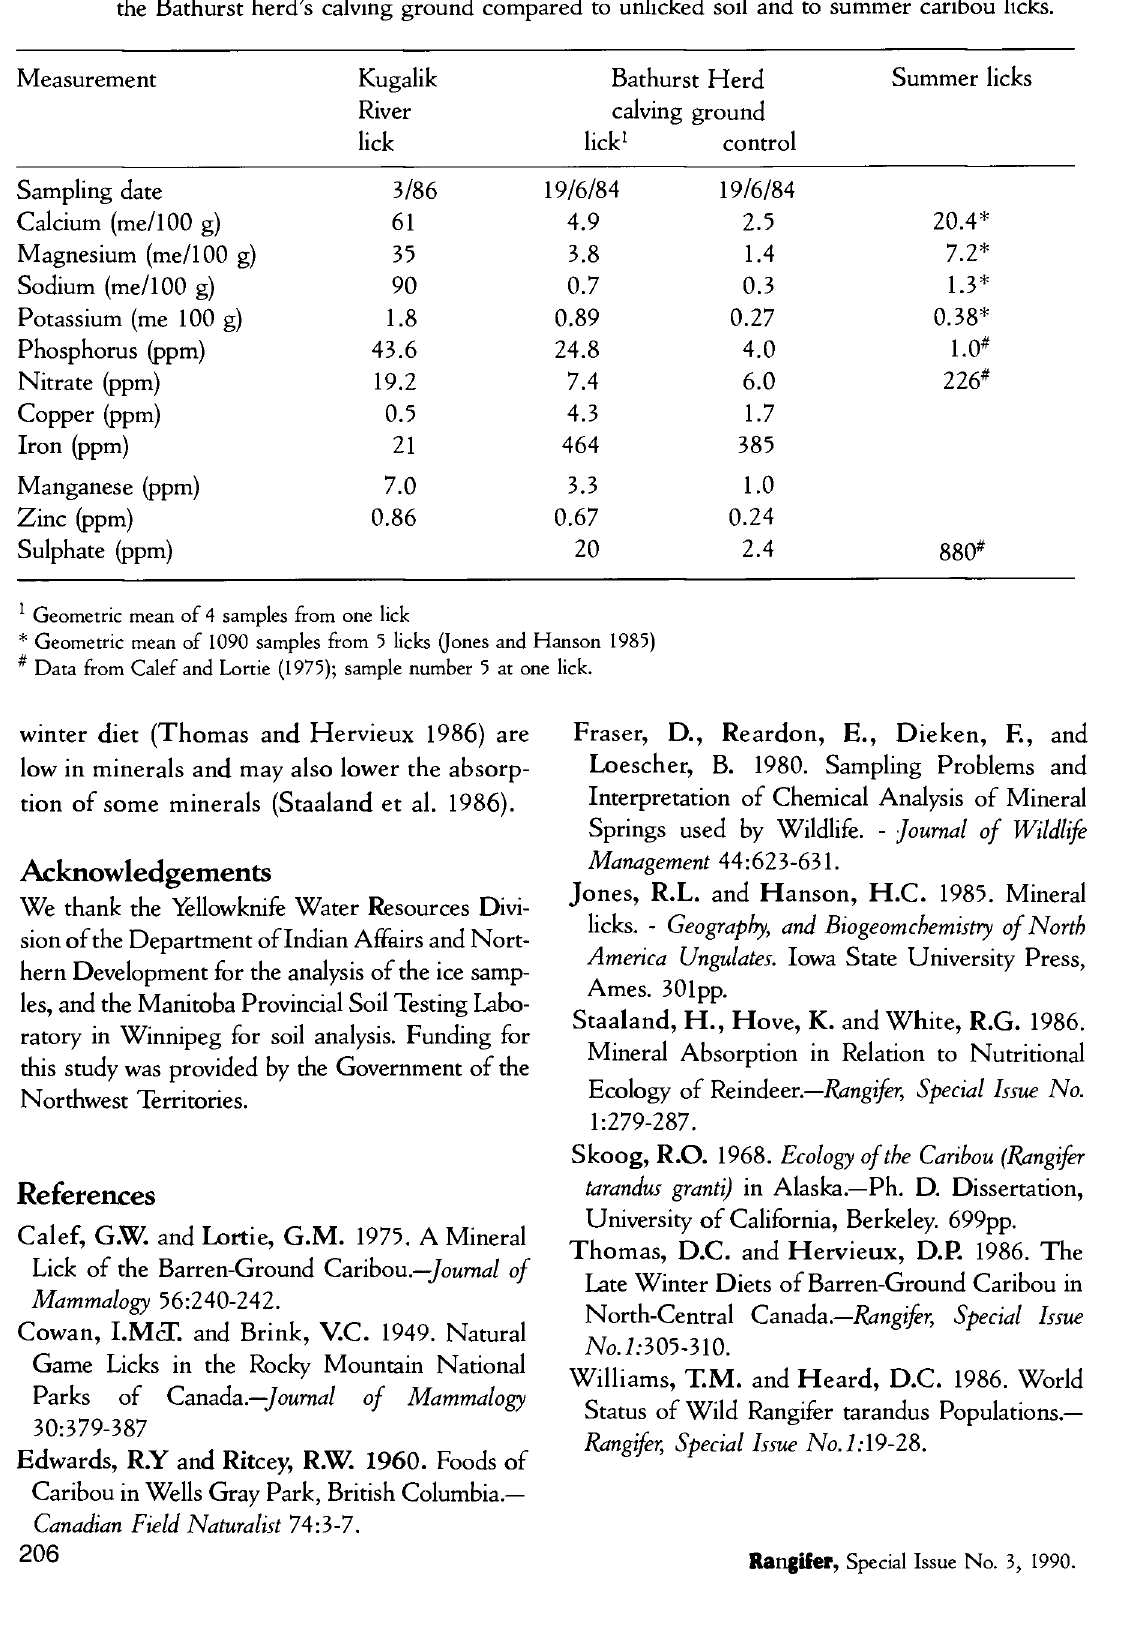
Table 2. Mineral composition of the soil lick being used in March 1986 near the Kugalik River and on the Bathurst herd's calving ground compared to unlicked soil and to summer caribou licks.